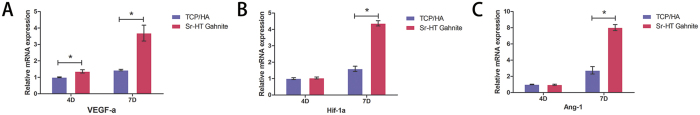
The expression of angiogenesis related genes: VEGF-α (A), HIF-1α (B) and ANG-1 (C) were measured by real-time PCR at day 4 and 7 after ASCs were cultured in optimal dissolution products of the two materials.